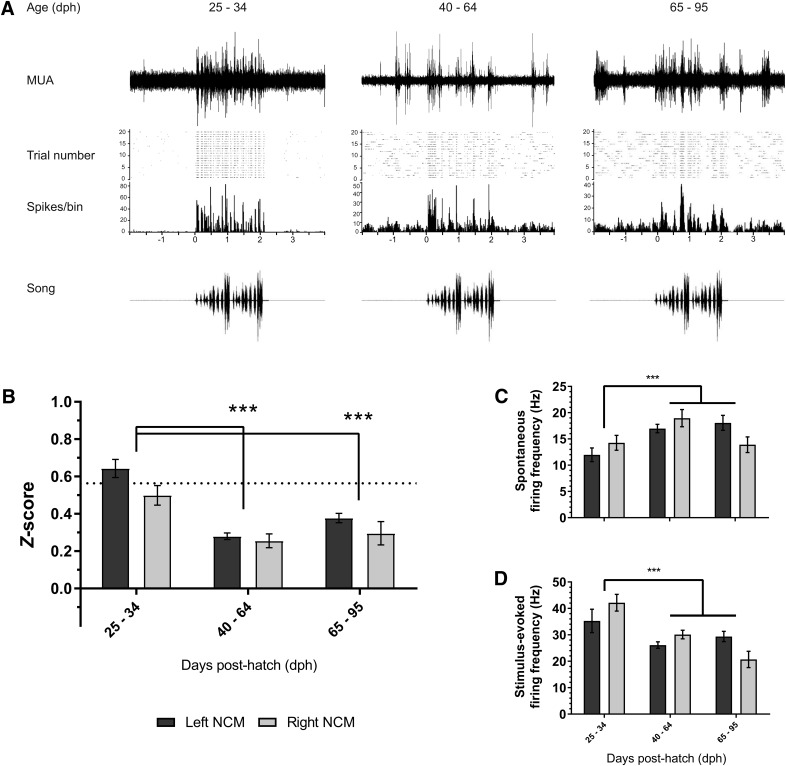
Multiunit shifts in NCM auditory responsiveness across development. A, Representative multiunit recordings from a 25-, 47-, and 95-dph subject (right, left, and left hemisphere, respectively). Top: Representative response to a single presentation of conspecific song (CON2) from a multiunit recording during Trial 1 (aCSF). Middle: Raster plot and corresponding peristimulus time histogram (6-s duration) across all CON2 presentations during Trial 1 (aCSF). Bottom: CON2 sonogram. B, 25–34 dph subjects have higher normalized auditory response than both 40–64 and 65–95 dph birds. Dotted-line in B is average CON z-score from adult male NCM recordings from a separate study (graphed for visual comparison; n = 4 birds [195–360 dph; average age = 267.7 dph]). C, D, Based on z-score results, we analyzed birds based on critical period phase (sensory [25–34 dph] vs. sensorimotor [40–95 dph]) and found that sensory-aged birds’ NCM have lower spontaneous firing rates (C) and elevated stimulus-evoked firing rates (D) compared with sensorimotor-aged subjects. ***p < 0.001 (z-score: 25–34 dph vs. 40–64 dph, and 25–34 dph vs. 65–95 dph; spontaneous and stimulus-evoked firing: sensory-aged versus sensorimotor-aged). MUA, multiunit activity; CON2, conspecific song 2.